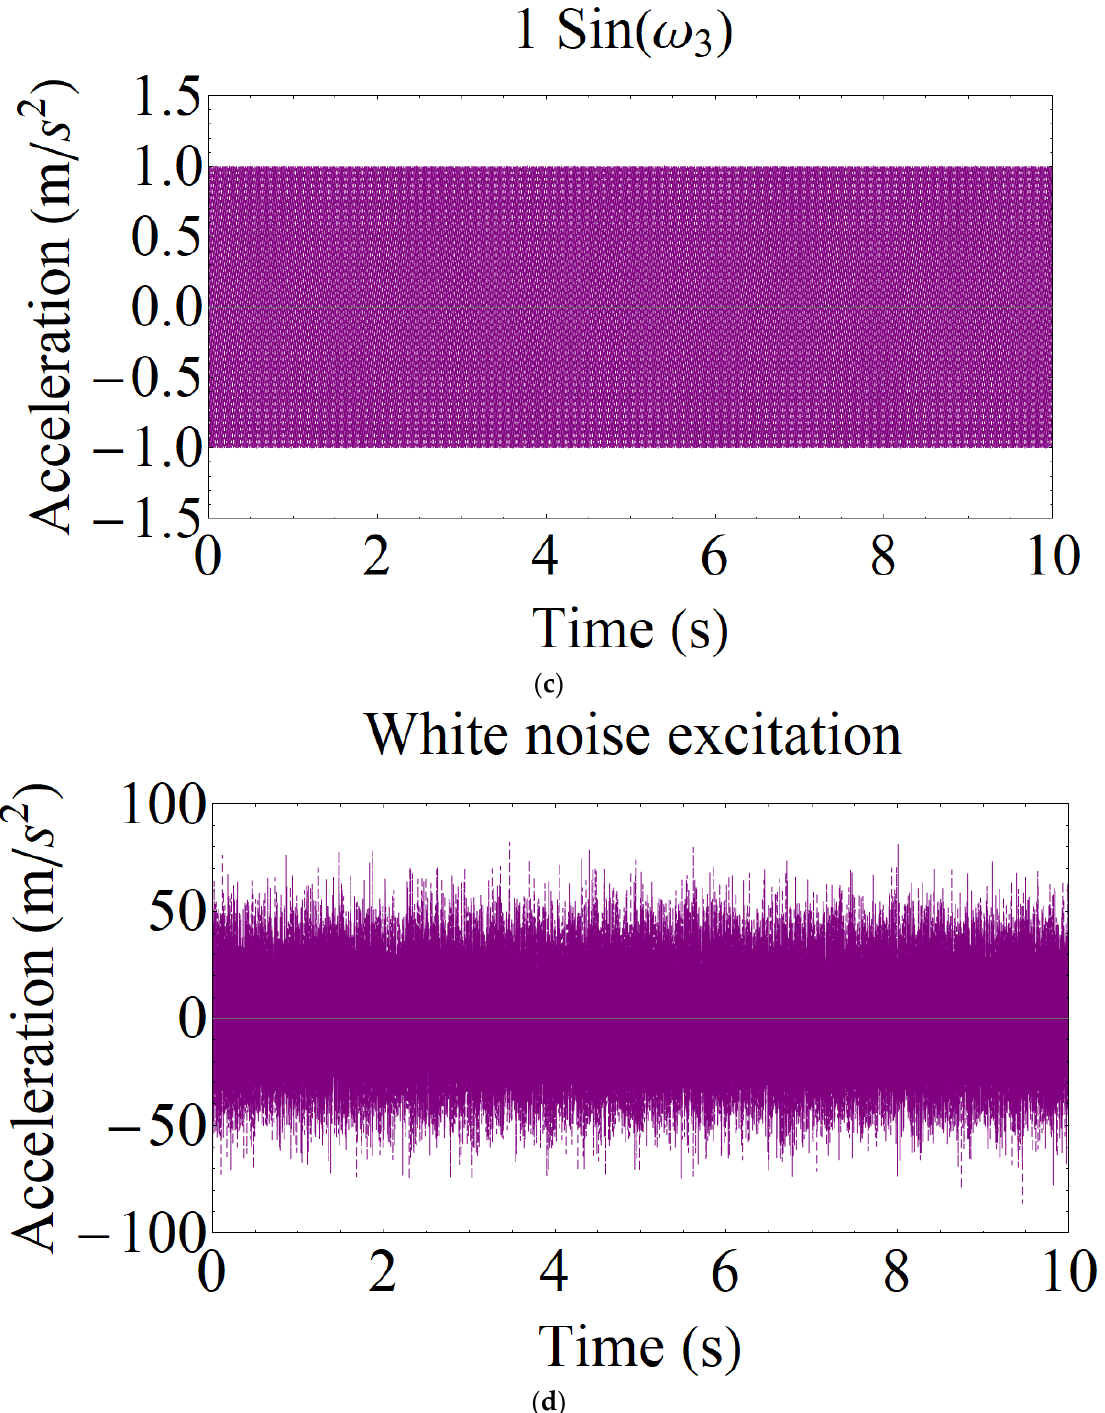
Figure 6. Disturbance base excitations: ( a ) 1 sin 𝜔 (cid:2869) 𝑡 , ( b ) 1 sin 𝜔 (cid:2870) 𝑡 , ( c ) 1 sin 𝜔 (cid:2871) 𝑡 , and ( d ) white noise excitation.